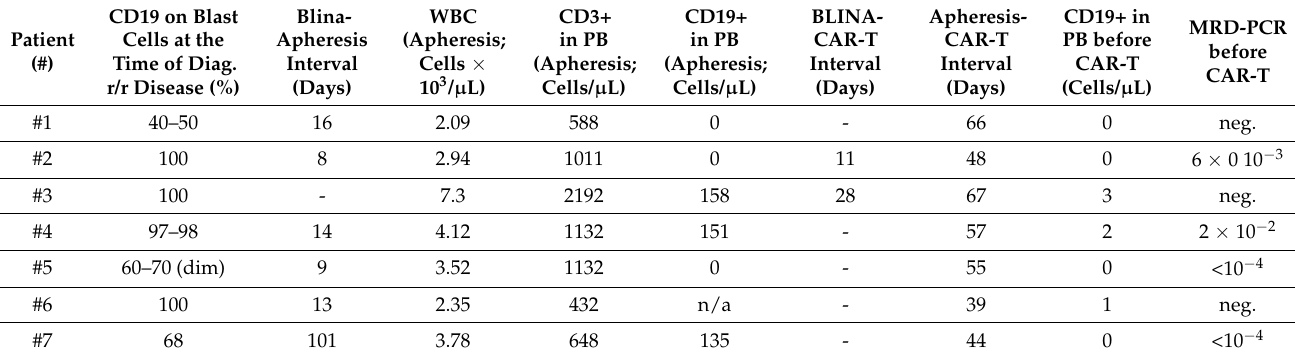
Table 2. Details of apheresis and CAR-T infusion; abbreviations: Blina—blinatumomab; CD3+—CD3+ lymphocytes; CD19+–CD19+ lymphocytes; n/a—not assessed, neg.—negative; WBC—white blood cells, PB—peripheral blood, r/r—relapsed or refractory